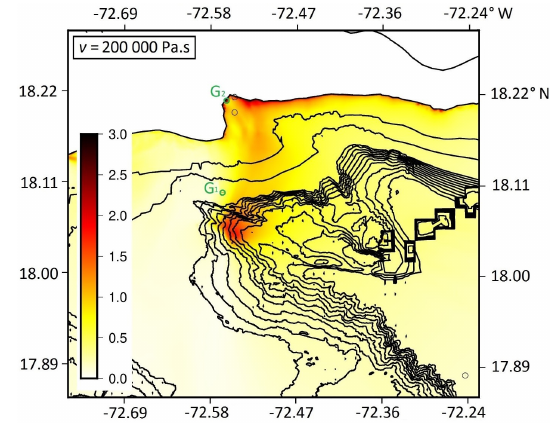
Figure 8. Maximum modeled wave height using a viscosity v = 2 × 10 5 Pas for the sliding